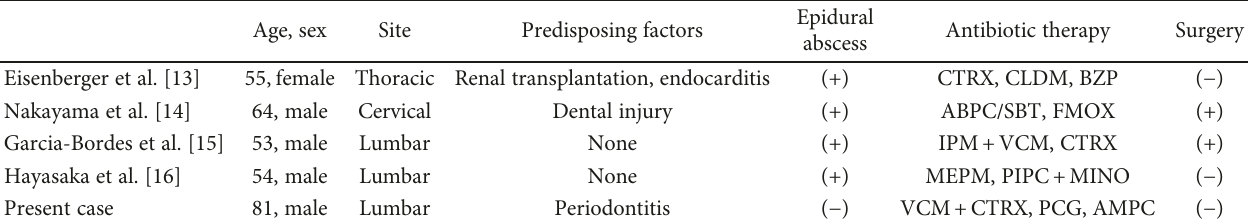
Table 2: Characteristics of spondylodiscitis caused by G. morbillorum